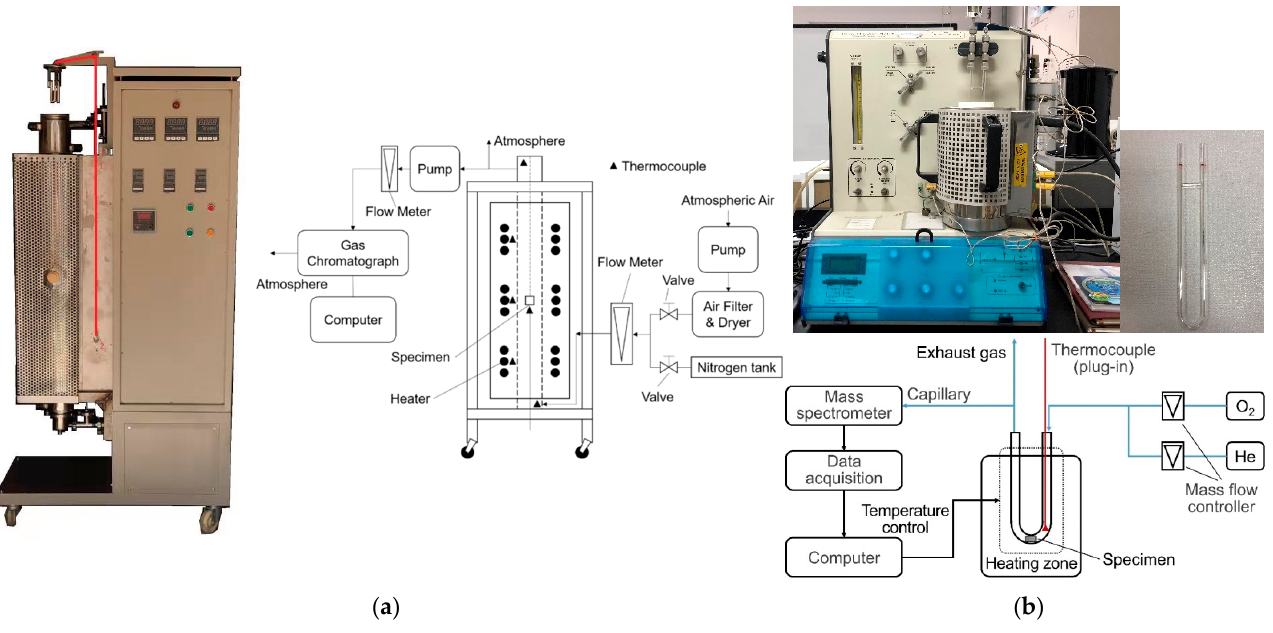
Figure 2. Test facilities used to oxidize different specimens: ( a ) test facility [25] based on recommended conditions of ASTM D7542; ( b ) test facility for oxidizing millimeter specimens in a U-tube.